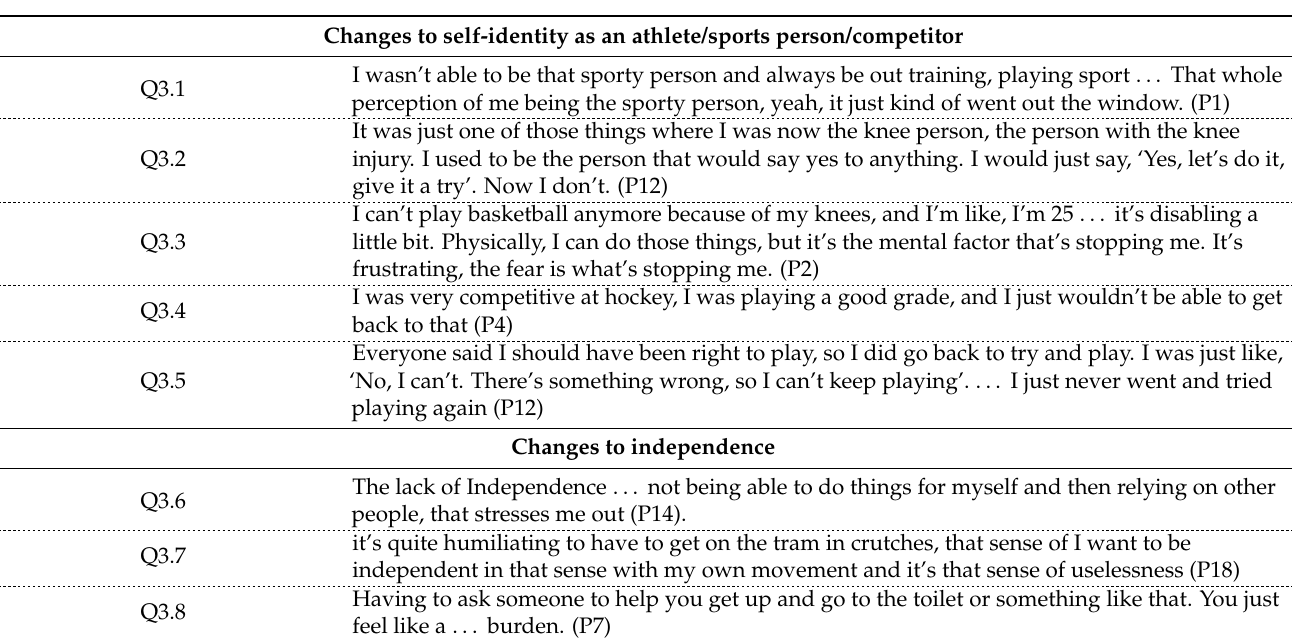
Table 4. Supporting quotes to theme 3—threat to identity and independence driving fear.